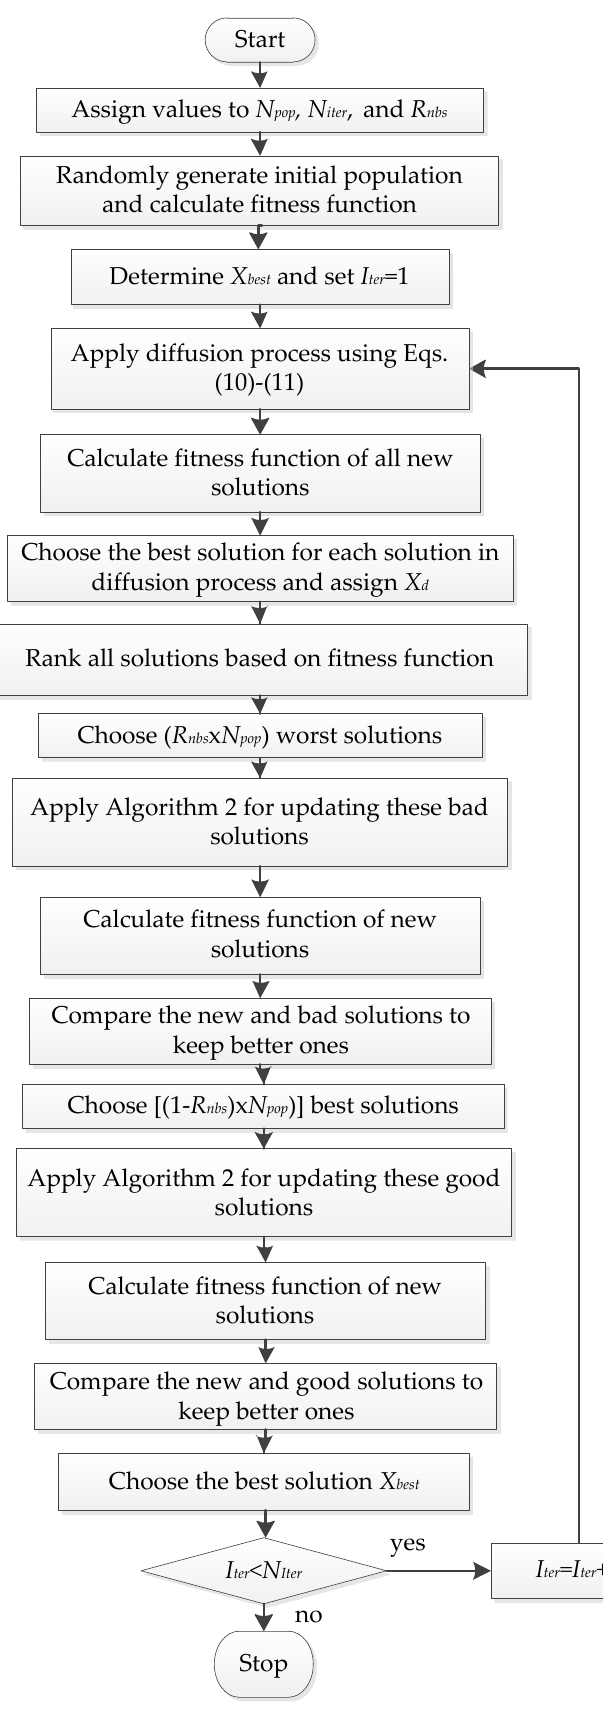
Figure 5. The flowchart of using the proposed method for solving a typical optimization problem.